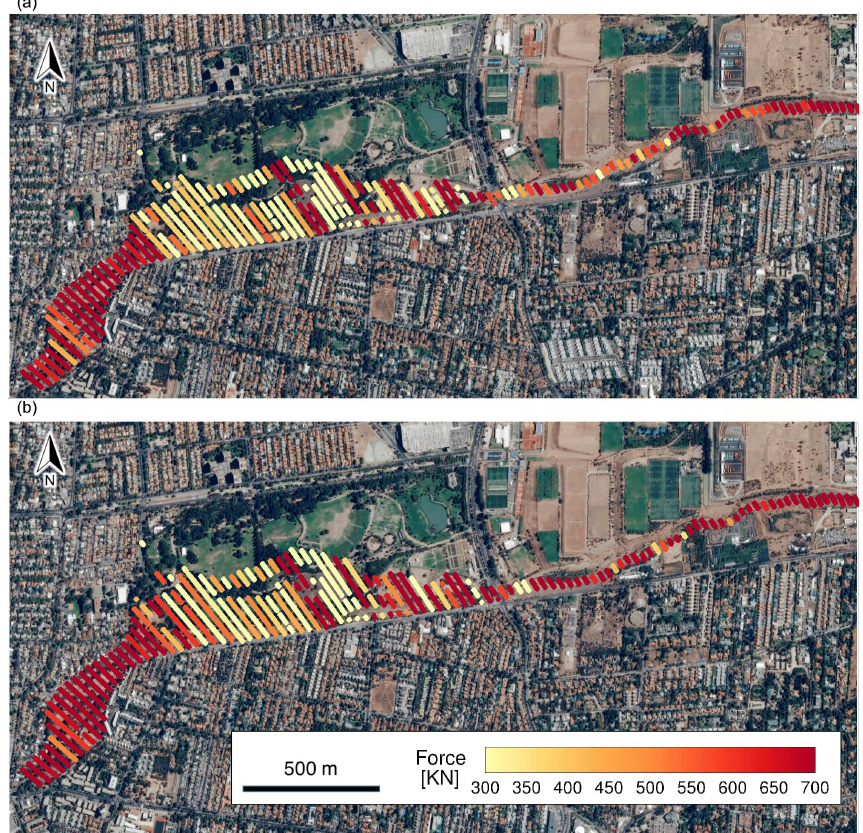
Figure 13. Maximum momentum of the flow in the urban area. Panel (a) shows results for a concentration of 20% coming from the Quebrada de Ramón stream and 60% from the Quillayes stream. Panel (b) corresponds to the opposite case, 60% from the Quebrada de Ramón stream and 20% from the Quillayes stream. Image of the terrain from © Google